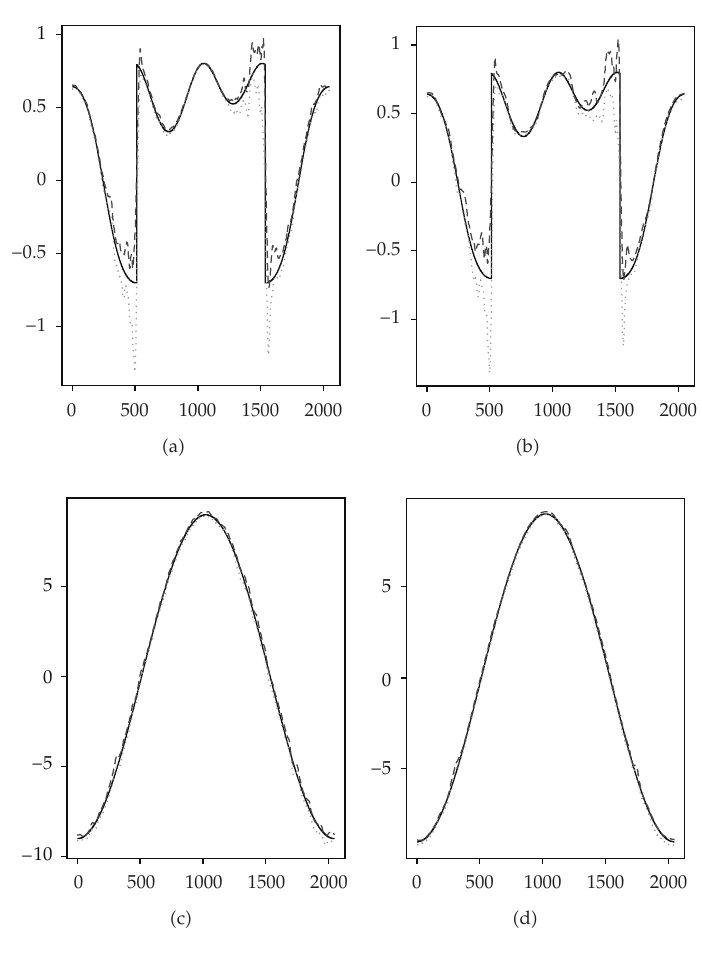
Figure 8: Example 5.2: Bootstrap 95% confidence regions for linear estimators, (cid:5) a (cid:6) and (cid:5) c (cid:6) , and nonlinear estimators, (cid:5) b (cid:6) and (cid:5) d (cid:6) , with true curves